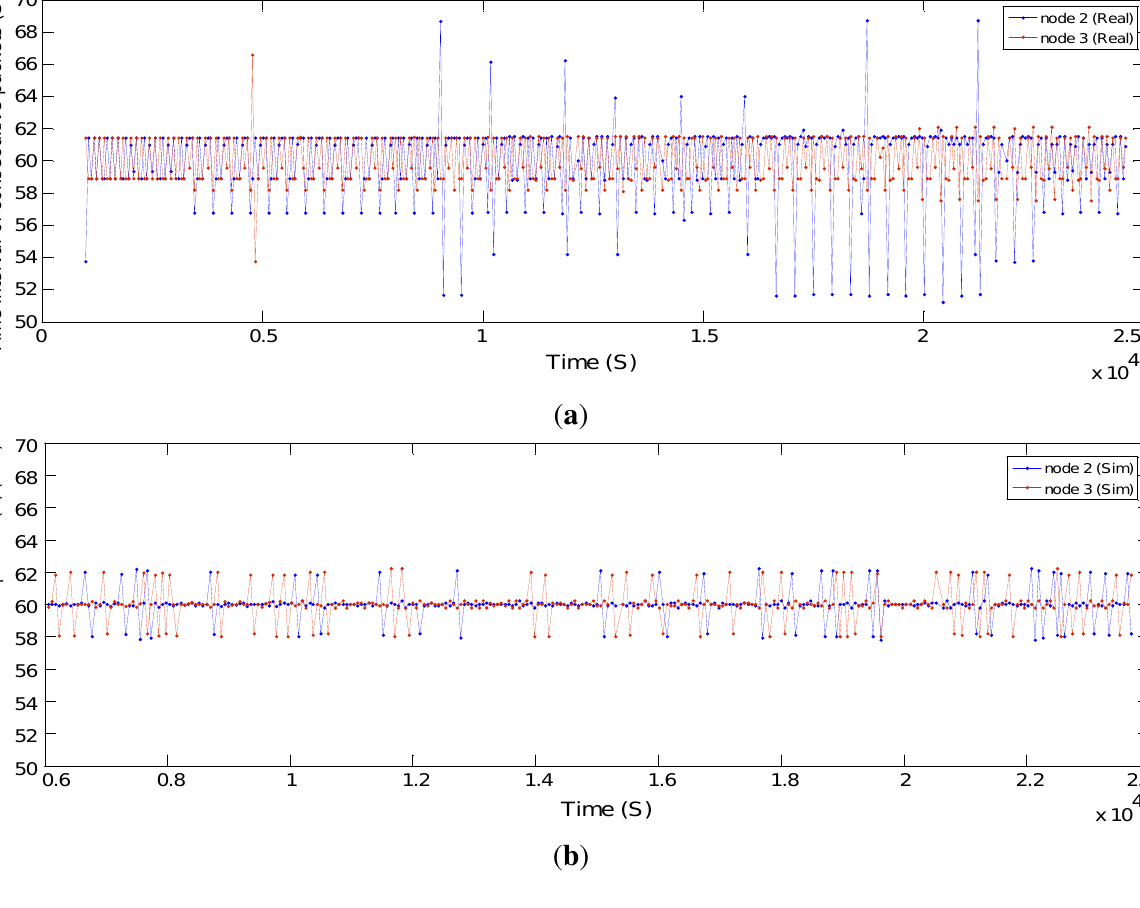
Figure 18. The time interval of the consecutive received packets for Nodes 4 and 5. ( a ) Real network; and ( b ) simulated network with a shadowing deviation of 8